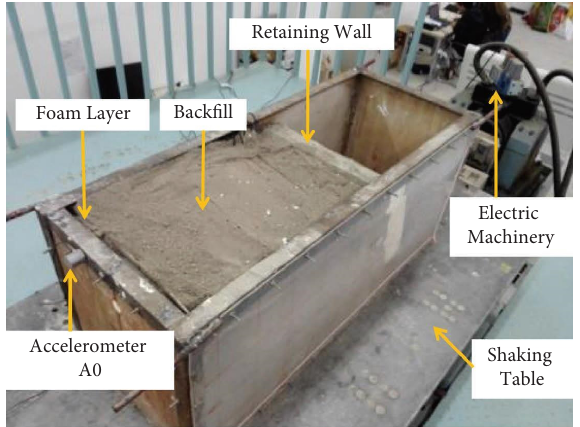
Figure 3: Experimental